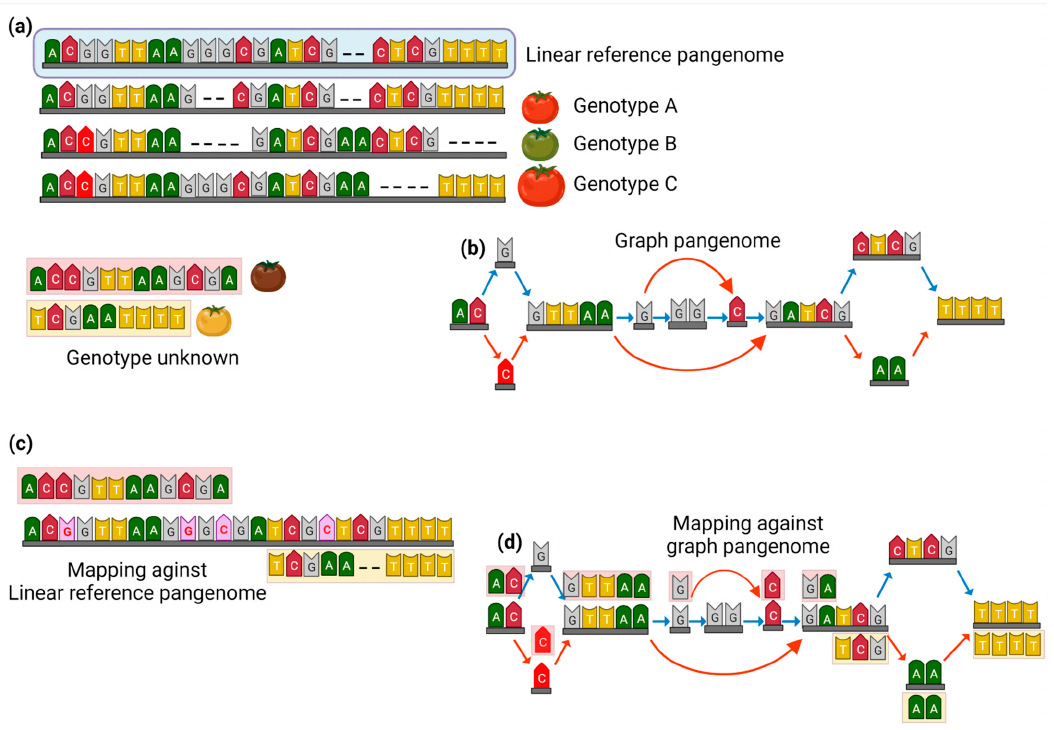
Figure 1. Schematic model of the graph pangenome that enhances the mapping efficiency of unknown genotypes against a reference genome. ( a ) A linear reference genome is constructed by aligning the mapped sequences of multiple accessions; ( b ) a graph pangenome is constructed from the aligned sequences, the red arrows (edges) show the variation in genotypes and provide additional paths for mapping against conserved regions (nodes); ( c ) mapping of unknown genotypes against linear reference pangenome may lead to mismatched and sequence gaps as information about variants is not ideally captured during this mapping approach; ( d ) graph pangenomes provide maximum coverage for mapping and avoid mismatches, and makes it possible to observe genetic variations with full-spectrum. For example, the unknown genotypes are mapped against graph-pangenome even having variants and gaps, and properly align to corresponding sequences through edges (red